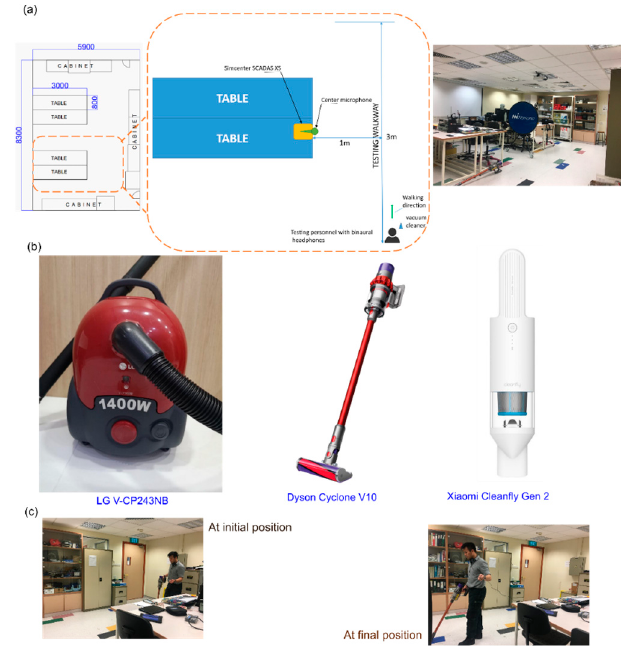
Figure 1. ( a ) Schematics of experimental setup plan. ( b ) Photographs of the three different vacuum cleaners. LG V-CP243NB (model type 1), Dyson Cyclone V10 (model type 2), and Xiaomi Cleanfly Gen2 (model type 3). ( c ) Photographs of the testing room displaying the vacuum cleaner